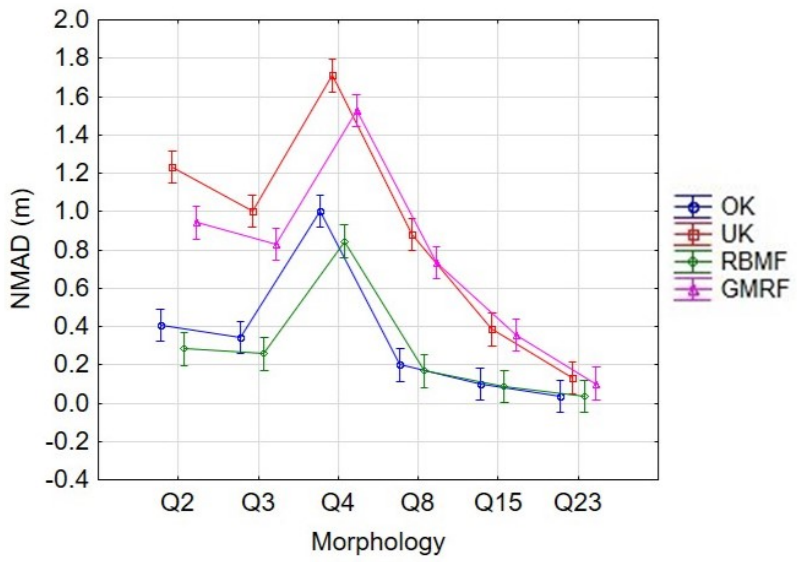
Figure 17. Plot of NMAD vs. Morphology for each interpolation method. Vertical bars denote 95% con fi dence intervals.